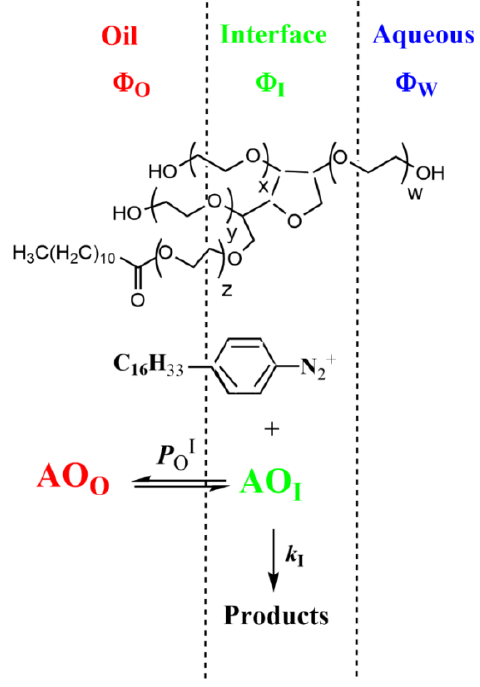
Scheme 6. Pictorial representation of the distribution of a water-insoluble antioxidant (e.g., tocopherols) and the location of the chemical probe 16-ArN 2+ . P OI is the partition constant of the antioxidant, k I the rate constant between the antioxidant and 16-ArN 2+ , and Φ O , Φ I , Φ W are the volume fractions of the oil (O), interfacial (I), and aqueous (W) regions. By applying the formalism of the pseudophase model (described in detail else- where) [21,30,74], Equation (5) can be